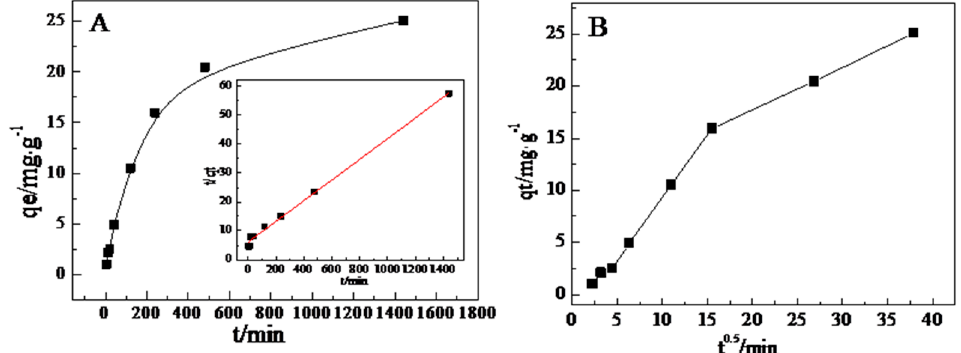
Figure 4. The adsorption kinetics of MPy-600 on Hg(II): ( A ) The pseudo-second-order model and ( B ) the Web-Morris model.